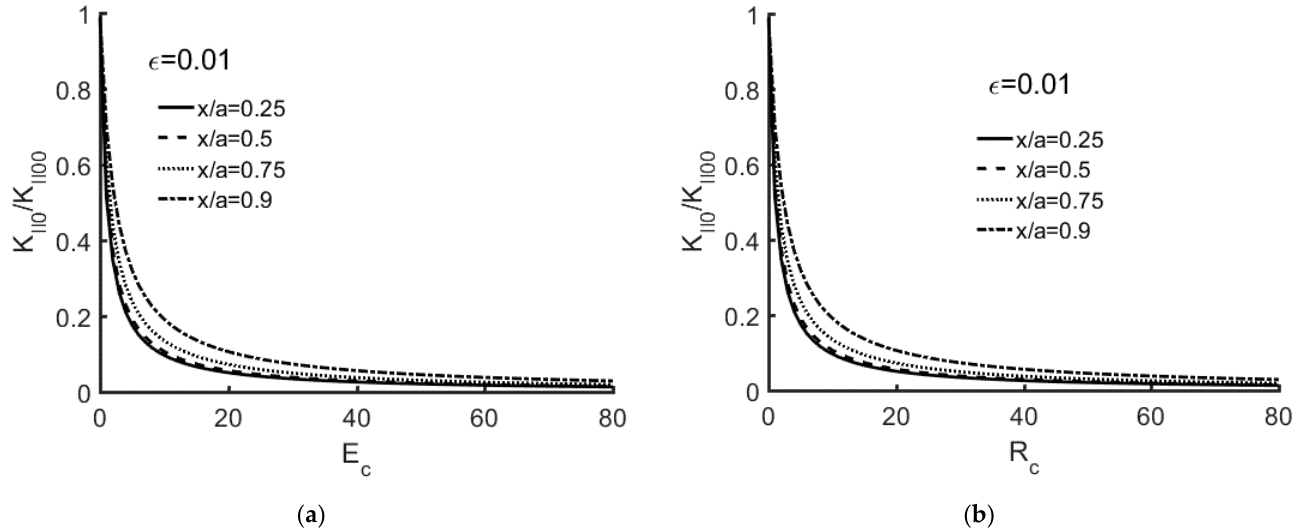
Figure 4. ( a ) K II0 /K I00 versus Ec with x / a = 0.25, 0.5, 0.75, 0.9 for ε = 0.01. The orthotropic material listed in Table 1; ( b ) K II0 /K I00 versus Ec with x / a = 0.25, 0.5, 0.75, 0.9 for ε = 0.01. The isotropic material listed in Table 2.